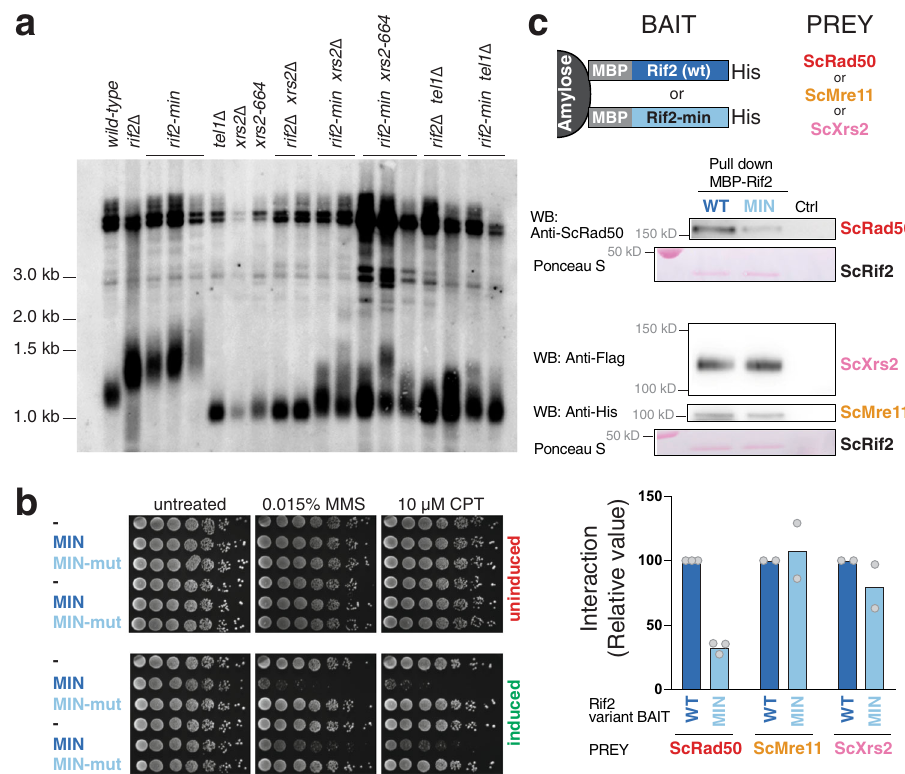
Fig. 2 The MIN motif of Rif2 counteracts the action of the MRX complex in promoting telomere elongation and promotes binding to Rad50. a Southern blot analysis of telomere length of Saccharomyces cerevisiae strains of the indicated genotypes. Genomic DNA was digested with Xho I and detected using a telomeric probe. ‘ Δ ’ indicates null alleles obtained by full deletion of the coding sequence. The rif2-min allele carries an F8E P10N substitution. b Viability assays of strains overexpressing a fusion protein containing the fi rst 34 amino acids of Rif2 under control of the galactose-inducible promoter, either in wild-type form (MIN) or mutant (MINmut, carrying the double F8E P10N substitution). Strains were grown in glucose-containing rich medium (YPAD) before plating onto either glucose (uninduced, top row) or induced (galactose, bottom row) plates containing the indicated chemicals and incubated at 30 °C for 2 – 3 days. c Protein interaction assays with immobilised wild-type or mutant Rif2 (Rif2-min) as bait, and Rad50, Mre11 or Xrs2 proteins used individually as prey. The bound proteins were separated by electrophoresis and detected by Western blotting (for Rad50, anti-Rad50; for Mre11-his, anti- his; and for Xrs2-FLAG, anti-FLAG), or by Ponceau S staining (for Rif2 wild-type or Rif2-min). CTRL lane is prey protein incubated with amylose resin without bait. A representative blot is shown, as well as a quanti fi cation of 2 – 3 independent ones, as indicated. Source data are provided as a Source Data fi